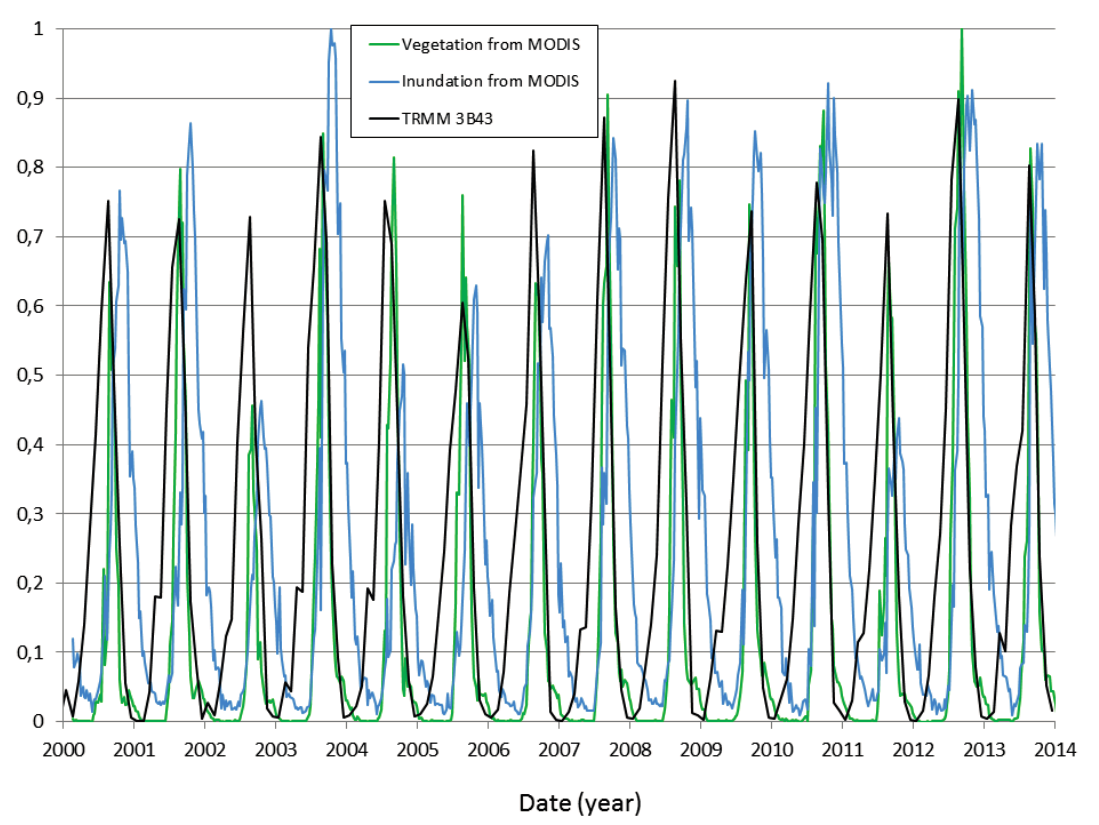
Figure 13. Time series of monthly precipitation over the Region Of Interest (ROI) compared to inundated surfaces over the Inner Niger Delta (IND) including open water, mixture of water and dry land and aquatic vegetation, and to vegetation total extent. All data has been normalized for the